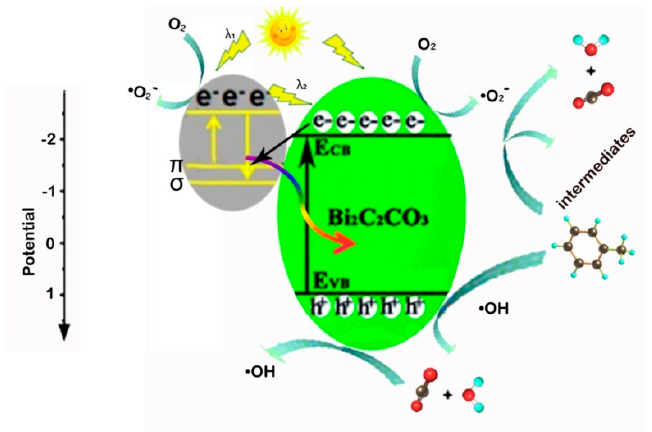
Figure 8. Photocatalytic mechanism of toluene removal for BOC-CQD-15.